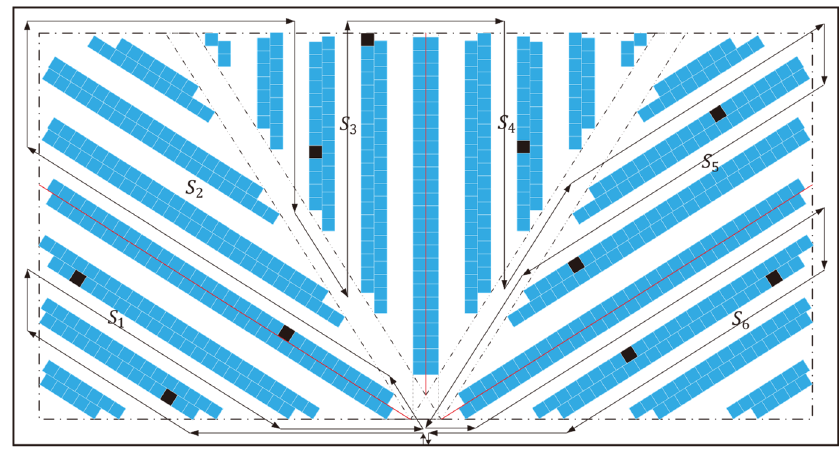
Figure 3. The S-shape strategy in the leaf layout warehouse.